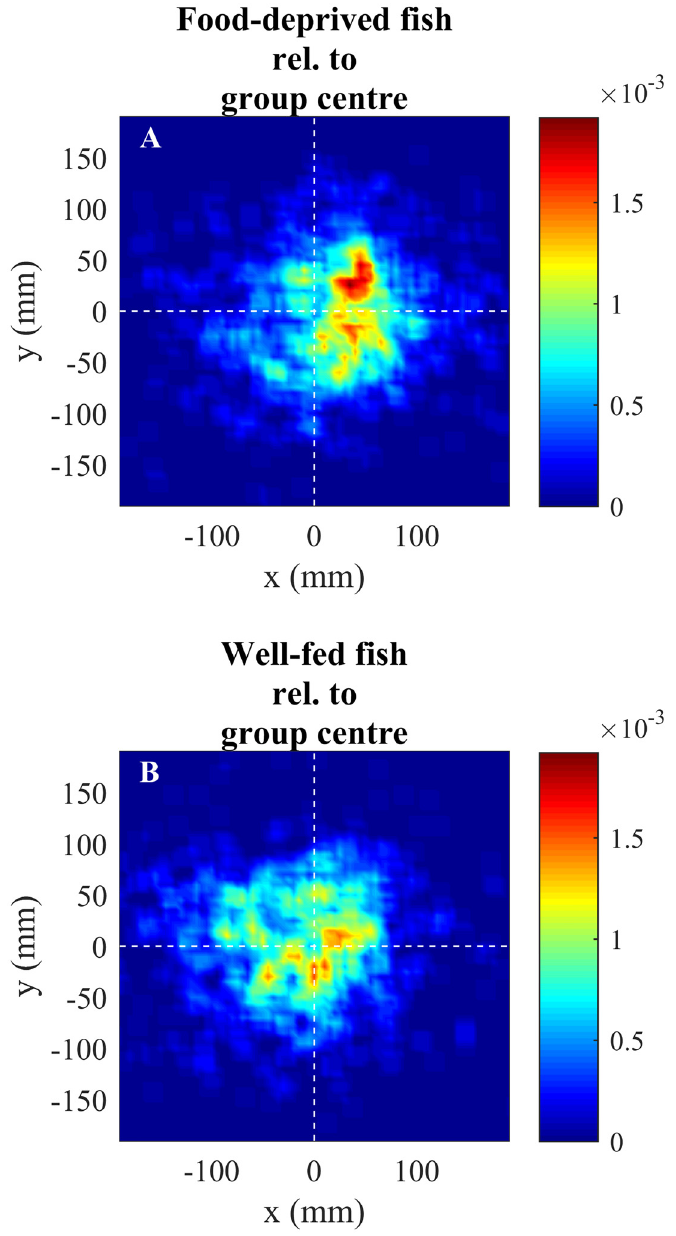
overlapping square bins (see Data collection and processing for more